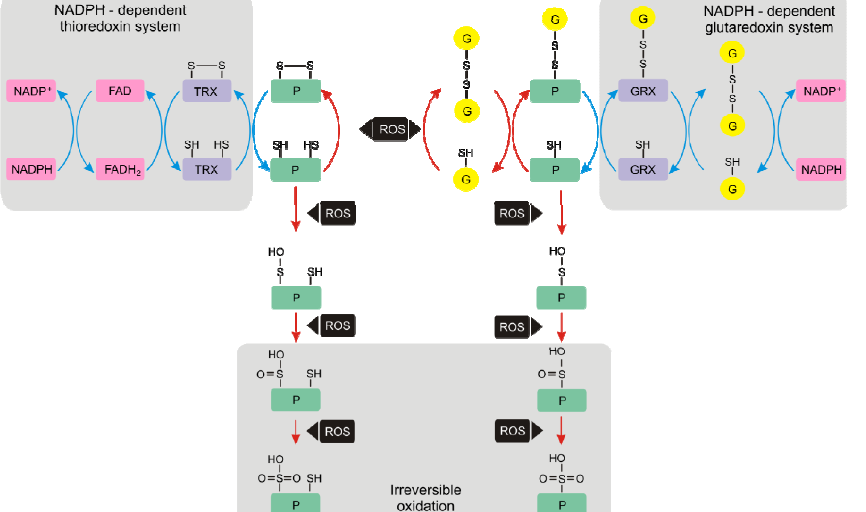
Figure 2. Thiol-disulphide cycle, proposed to contribute to the biochemical mechanisms that confer desiccation tolerance, involving glutathionylation of proteins, GRX and TRX. This figure is reproduced from Colville and Kranner [14], with the permission of Plant Growth Regulation. Desiccation tolerant organisms can lose more than 90% of their water without dying and revive upon rehydration, and extreme fluctuations in water content are accompanied by equally extreme changes in cellular redox state, associated with an increase in ROS levels. Red arrows: processes that may occur predominantly during desiccation; blue arrows: processes that occur primarily during rehydration. The thiol (-SH) groups of redox-active Cys residues in proteins (P; green) and glutathione (G; yellow) are susceptible to oxidation, and in the dry state, a shift from thiols to the disulphide forms occurs as the probability for enzymatic reduction decreases with progressive water loss. Glutathionylation protects protein Cys residues from further oxidation to sulphenic (PSOH), sulphinic (PSO H) and sulphonic 2 (PSO H) acids. Sulphenic acid can be reduced by glutathione, whereas sulphonic and sulphinic 3 acid formation are thought to be irreversible. Glutathionylation may occur through several mechanisms, for example, through reactions between a protein thiol (PSH) and GSSG, forming protein-bound glutathione (PSSG). This will occur under conditions of severe oxidative stress when GSSG accumulates. Other mechanisms include reactions of protein thiyl radicals or sulphenic acid intermediates with GSH; glutaredoxins (GRX) can also catalyse the reaction between GS • and PSH to produce PSSG (not shown), although GRXs normally act as reductants in de-glutathionylation reactions. Upon rehydration, the reduction of protein disulphides can be catalysed by thioredoxin (TRX), which is subsequently reduced by TRX reductases (NADPH-dependent thioredoxin system). The NADPH-dependent thioredoxin system operates in the cytosol and mitochondria, where TRX reductases utilise electrons supplied by NADPH, which are transferred to TRX disulphide via flavoproteins (FAD). In chloroplasts, TRX reductases may use ferredoxin as an electron donor. Moreover, upon rehydration GRXs can reduce PSSG, leading to the formation of a mixed disulphide between GSSG and GRX. This is reduced by GSH, and the resulting GSSG is reduced by GR (NADPH-dependent glutaredoxin system). The active site of GRXs can either have one (monothiol) or two (dithiol) catalytic Cys residues; only the monothiol mechanism for PSSG reduction is